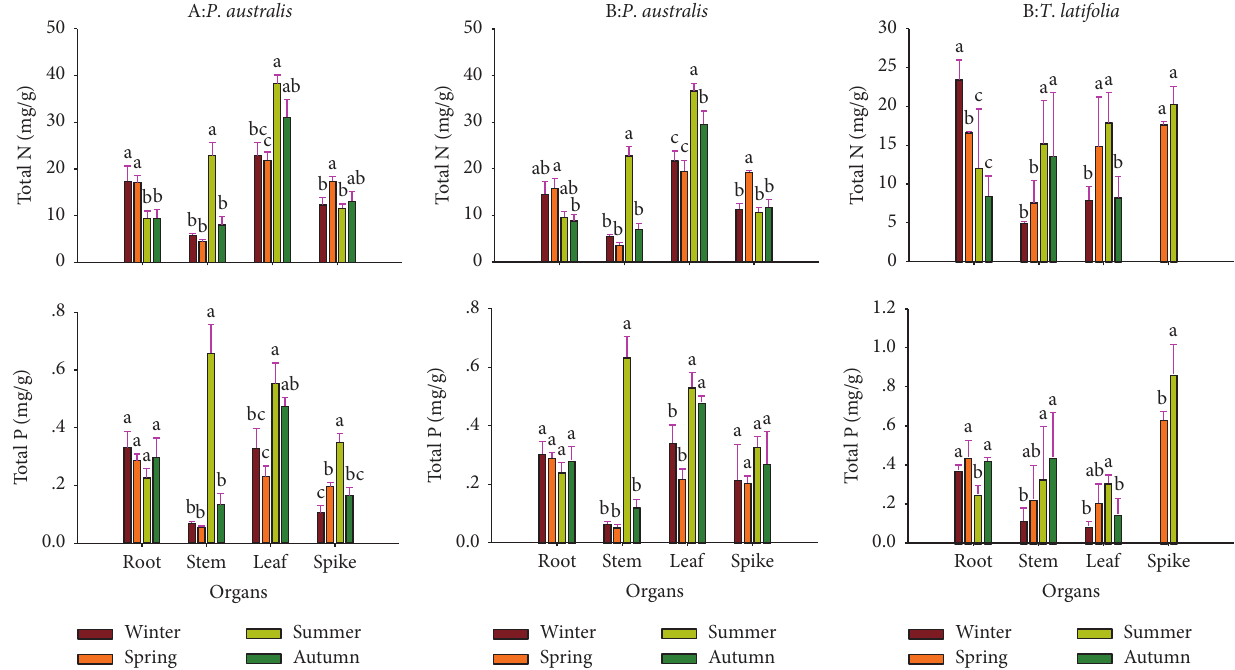
Figure 3: Seasonal dynamic concentration of TN and TP in the organs of P . australis and T . latifolia in experimental sites. The first and second columns of figure are the information of P . australis from sites A and B, and the third column is T . latifolia from site B. Different lowercase letters indicate significant difference among TN and TP contents of seasons ( 𝑃 < 0.05 ). Values are mean + 1